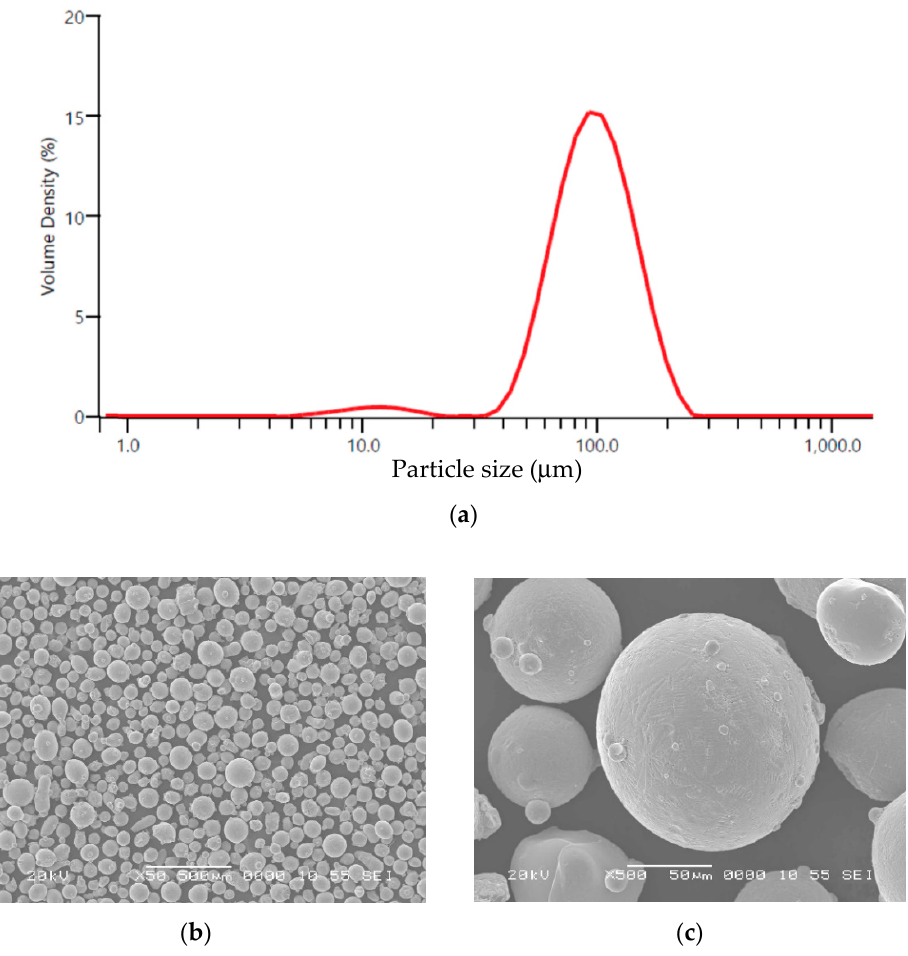
Figure 7. ( a ) Volume based particle size distribution of INCONEL 718 powders ( b ) SEM image of INCONEL 718 powder with low magnification ( c ) SEM image of INCONEL 718 powder with high magnification.